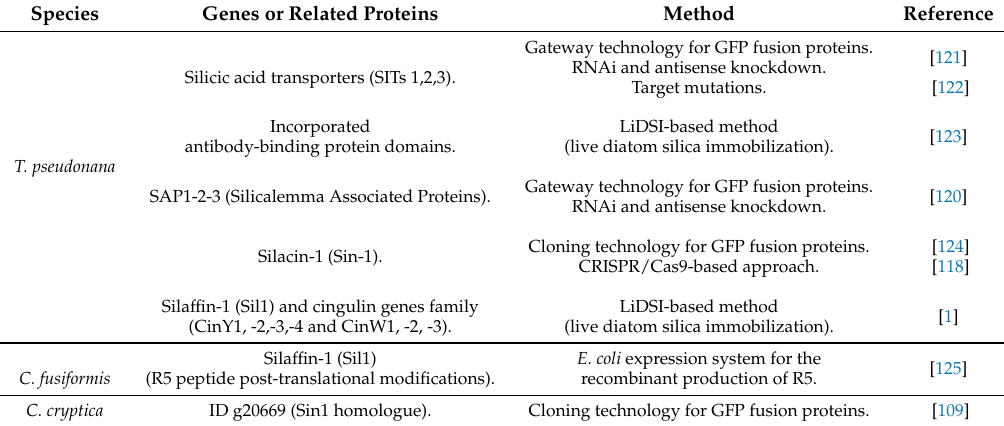
Table 1. Summary of the main model species used for frustule characterization with indication of the studied genes, encoded proteins and employed